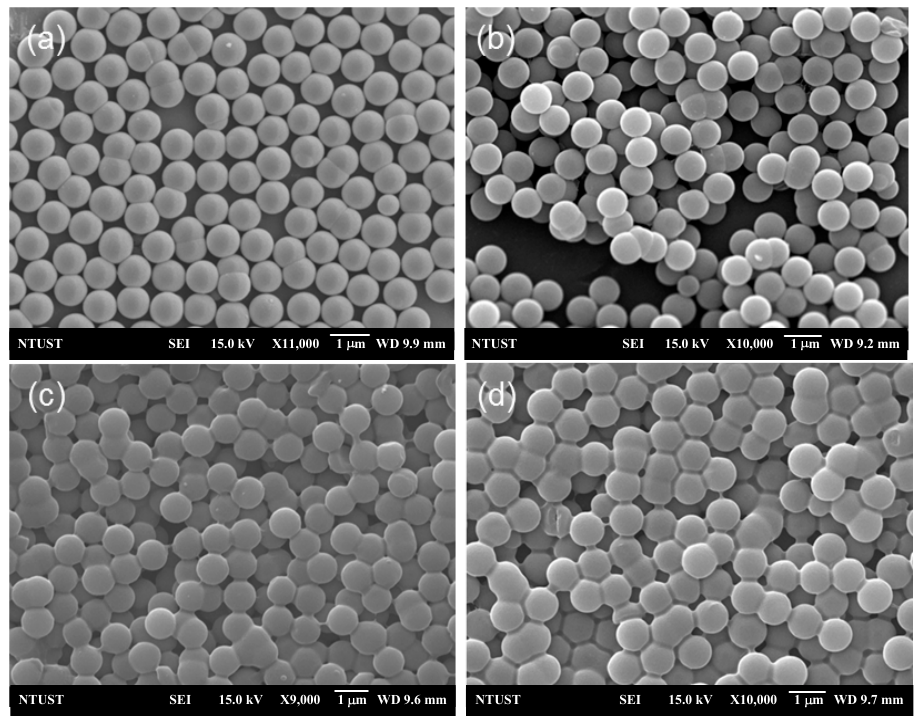
Figure 4. SEM images of ( a ) bare silica microspheres; ( b ) BiBB-functionalized silica microspheres; and SPMs incubated ( c ) below and ( d ) above the LCST.